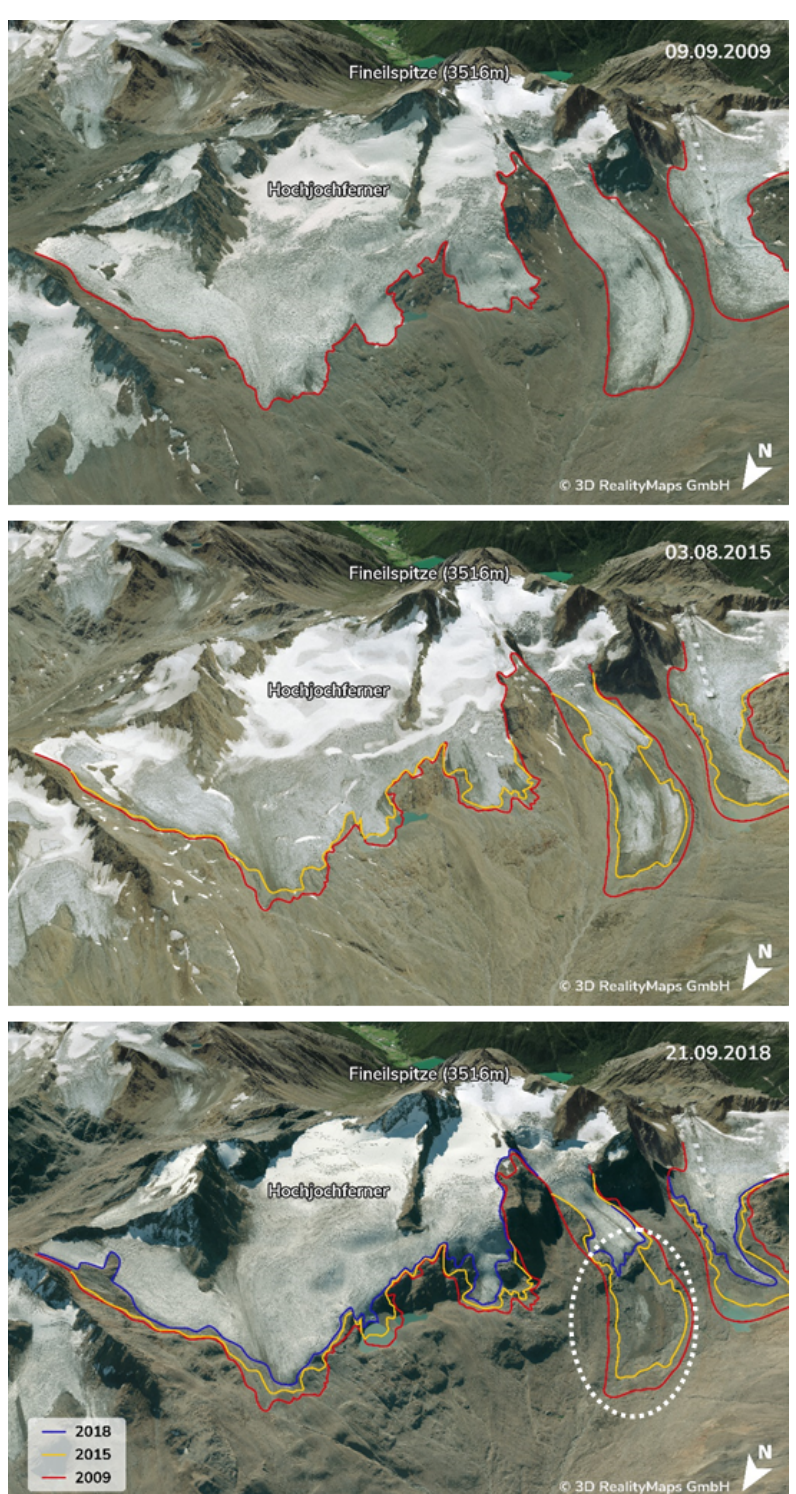
Figure 5. Three-dimensional visualization of the length change for the Hochjochferner in 2009 (top), 2015 (middle), and 2018 (bottom); lines indicate glacier extent for the respective years. The second glacier tongue from the right (white dotted circle) lost 826m in 9